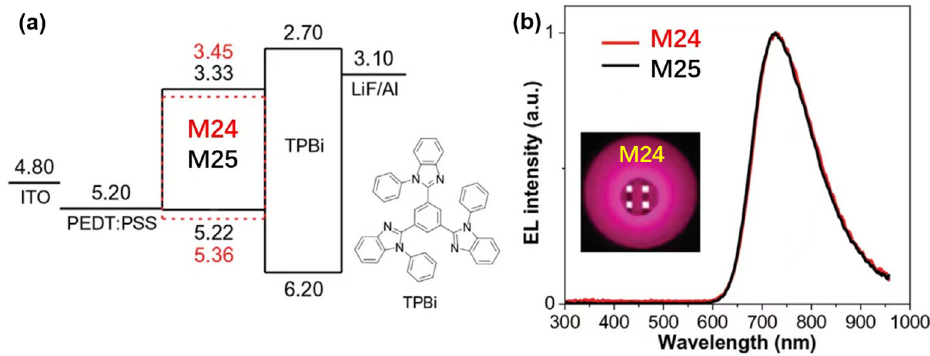
Figure 10. Chemical structures of M7 to M28 .